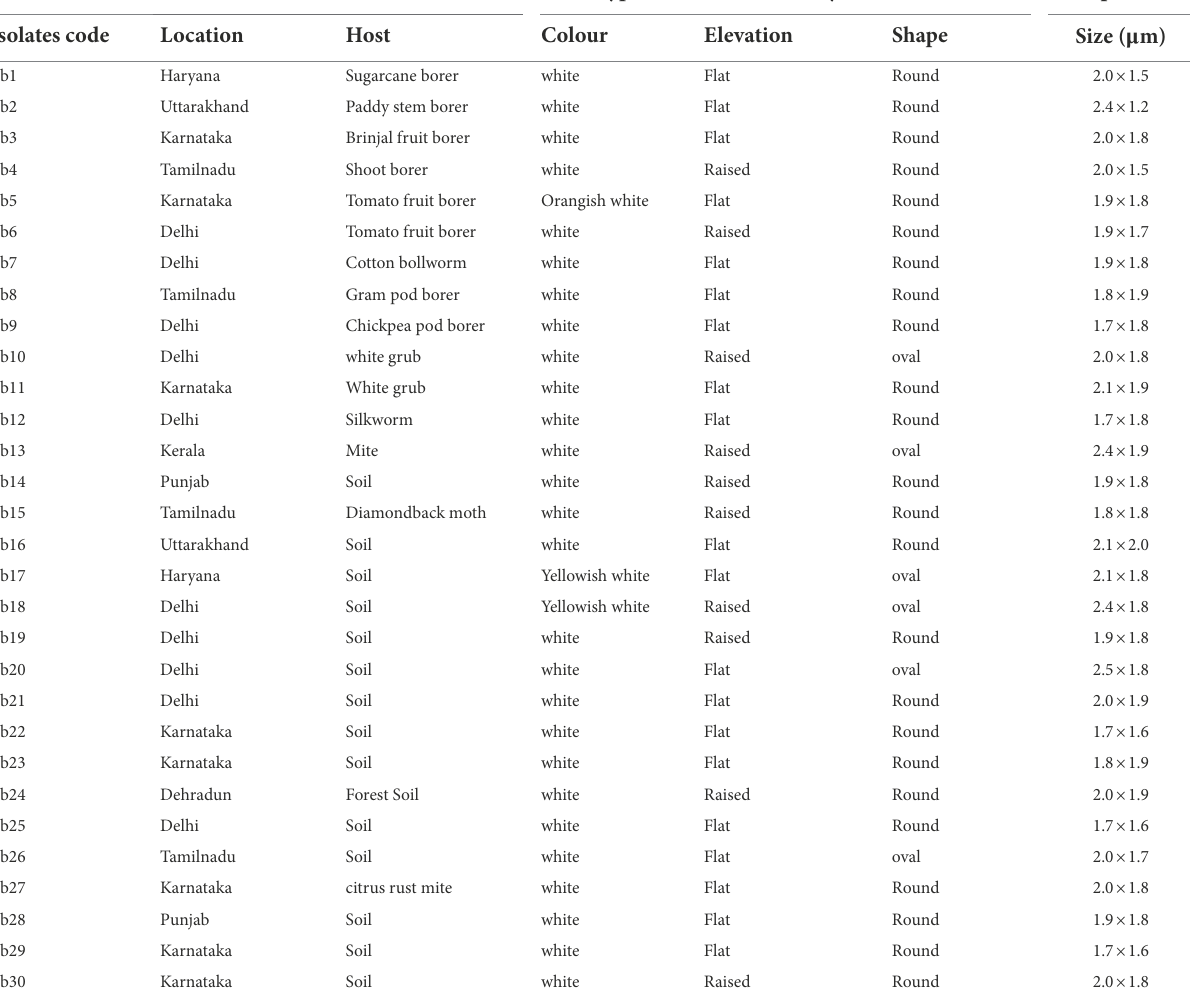
TABLE 1 Morphological characters of 30 isolates of B. bassiana collected from different locations at 16 DAI on Potato Dextrose Agar (PDA) medium.